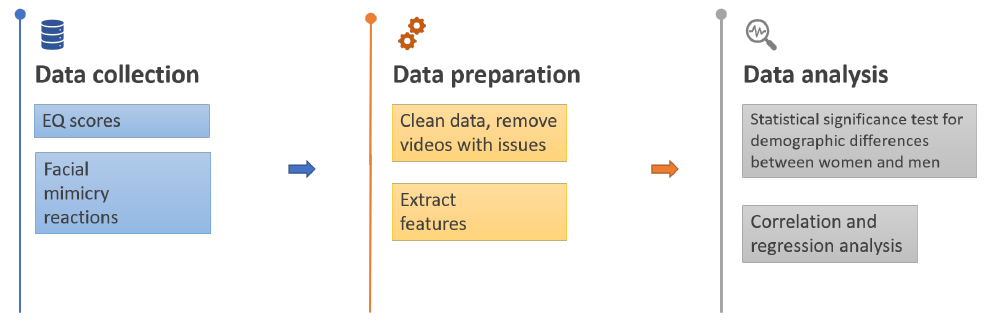
Figure 3. Architectural framework of the